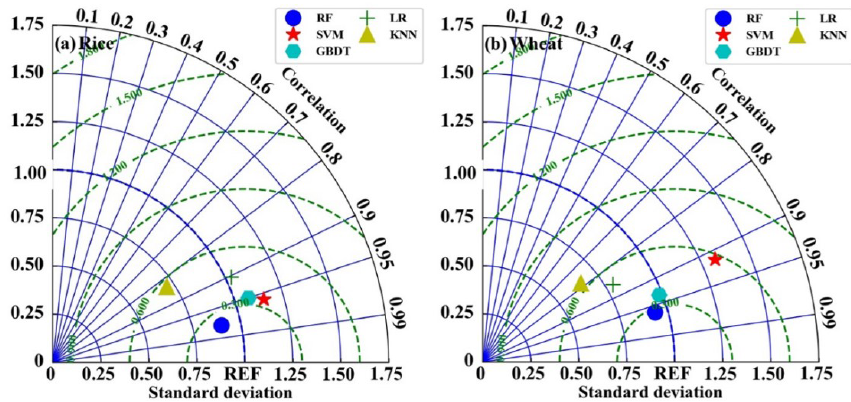
Figure 9. The same as in Fig. 8 but for